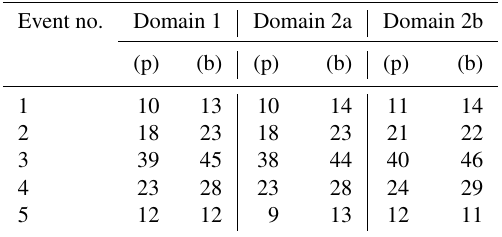
Table 4. Spatio-temporal mean absolute error (MAE) values (inmm) corresponding to WRF configuration (p) and configuration (b) for the three domains. Event